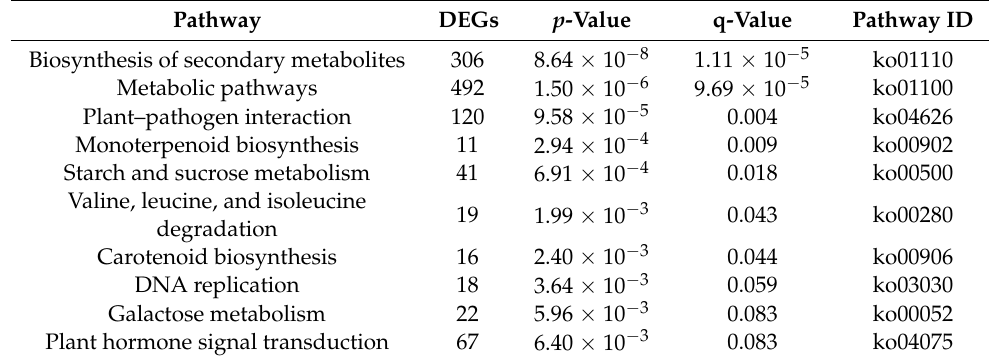
Table 2. KEGG pathways mapping enriched differential progress ( p < 0.01).